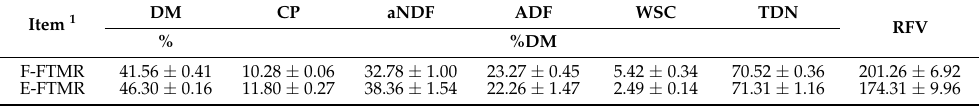
Table 3. The chemical composition of fresh-alfalfa and ensiled-alfalfa FTMR before